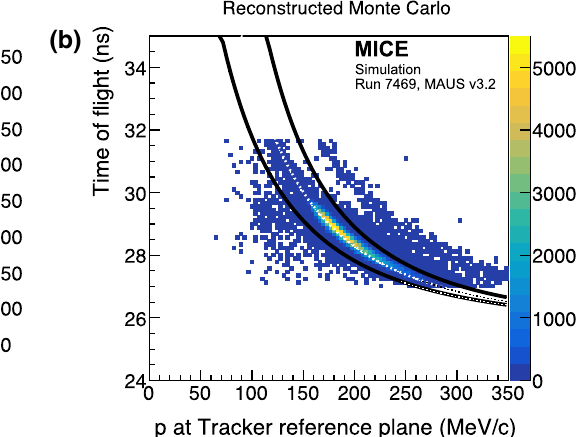
Cumulative surviving particles